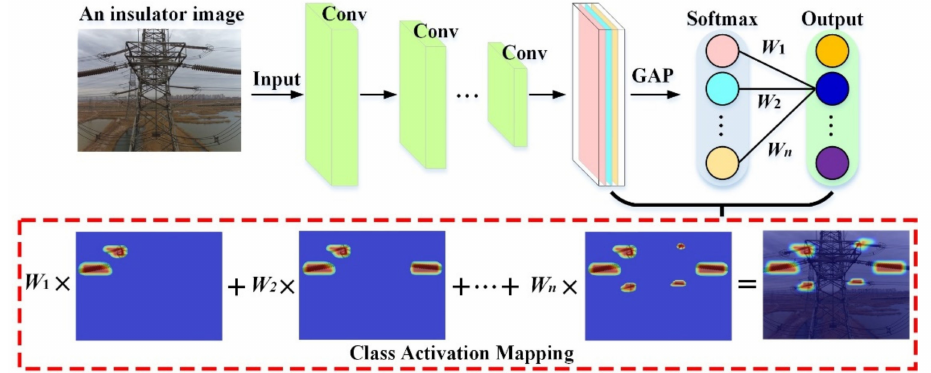
Figure 9. The class activation mapping process of an insulator